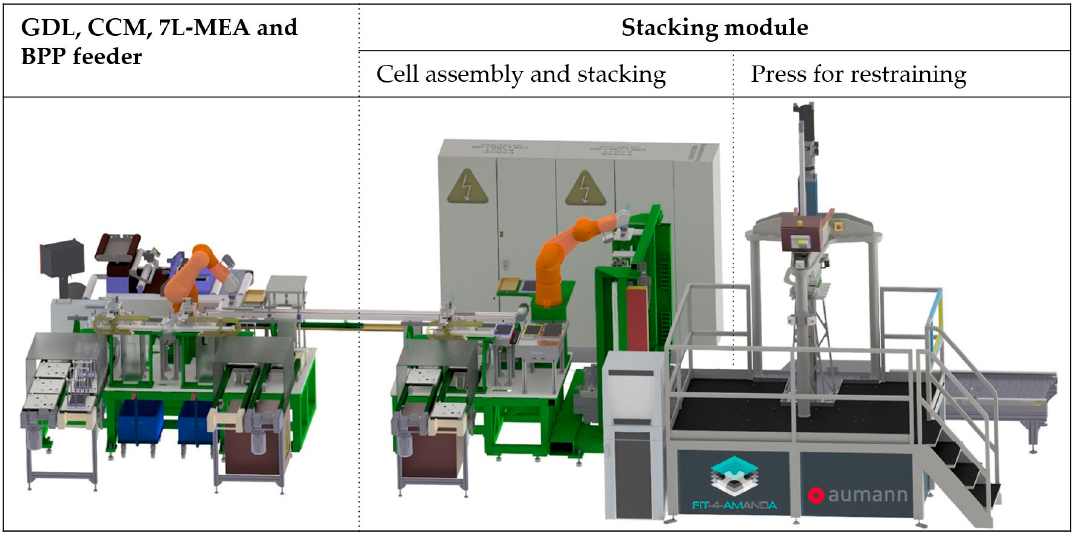
Figure 8. 3D-CAD layout of the plant for automated production and assembly of PEMFC stacks based on [24].